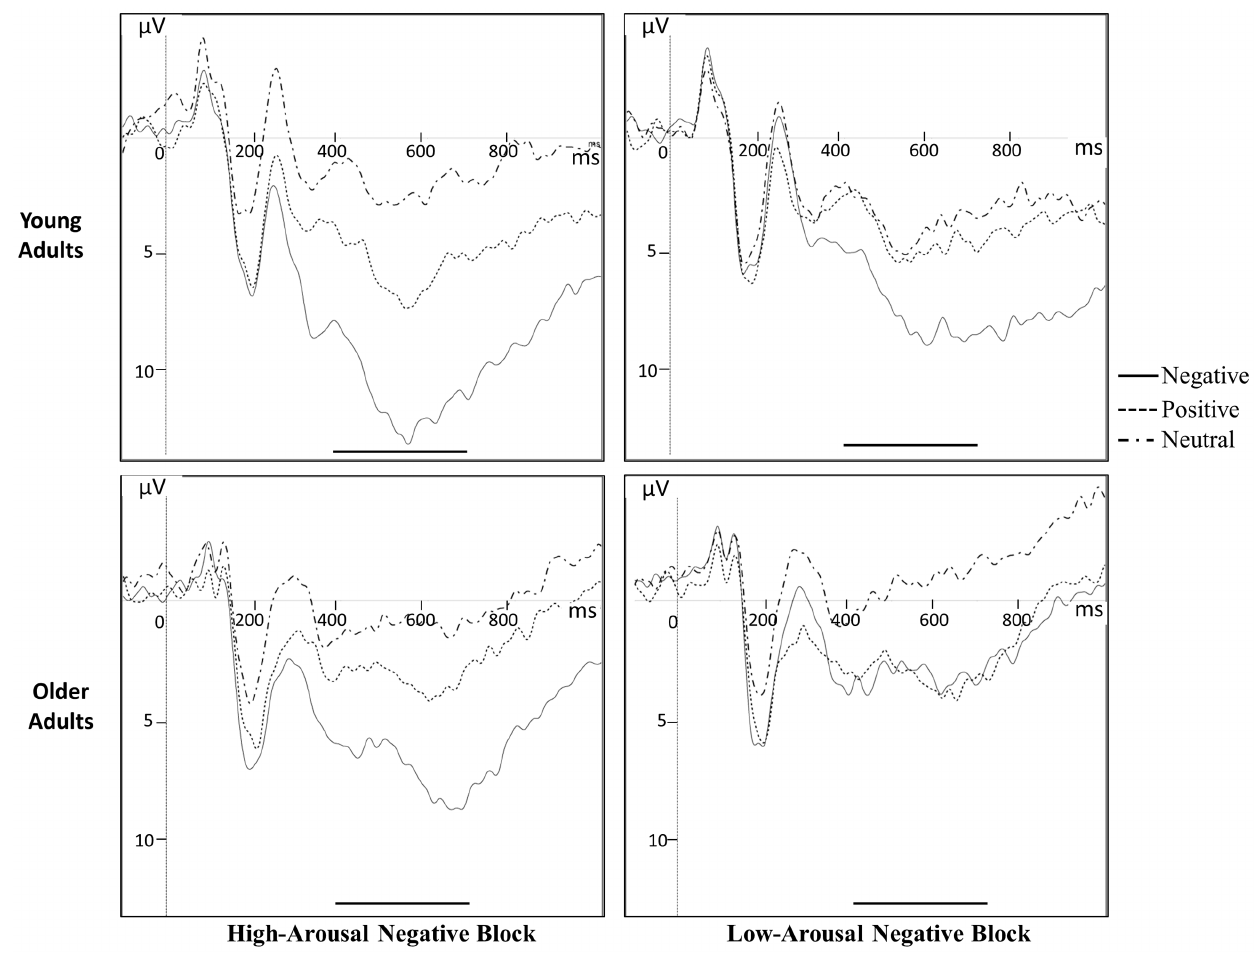
Figure 1. Group average of LPP at Pz electrode for the different experimental conditions in each age group. Positive values are oriented downwards. The continuous line, in bold, delimits the analysis time-window of LPP amplitude. post-hoc on data of the 3-way interaction Age x Contextual block